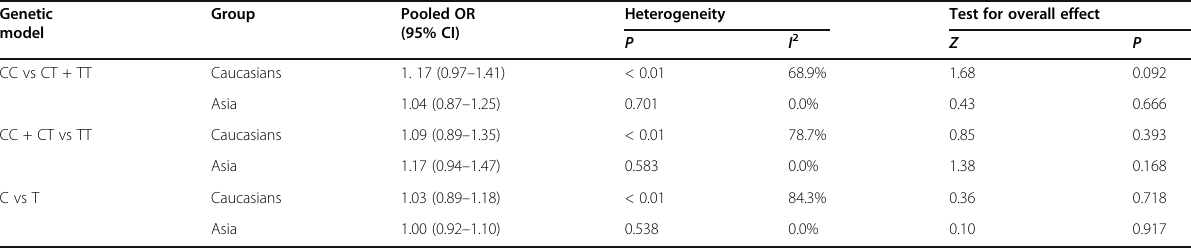
Group Pooled OR